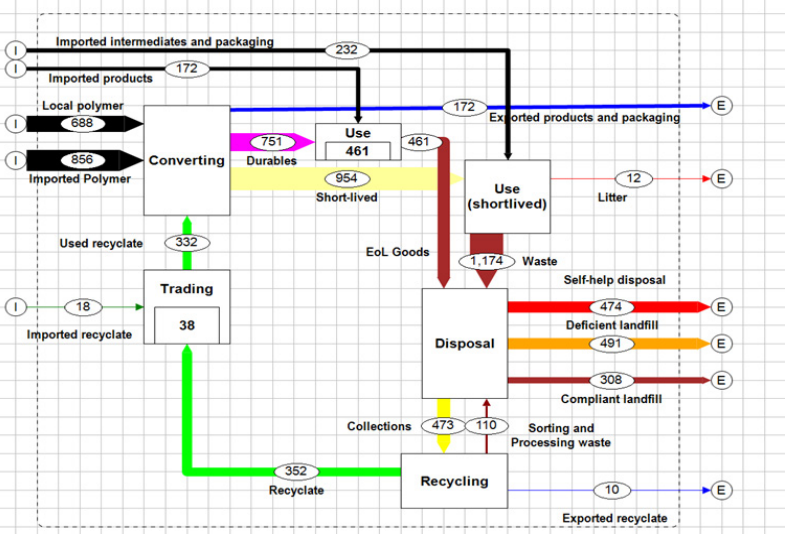
Figure 2: Sankey diagram depicting results of material flow analysis of plastics in South Africa for